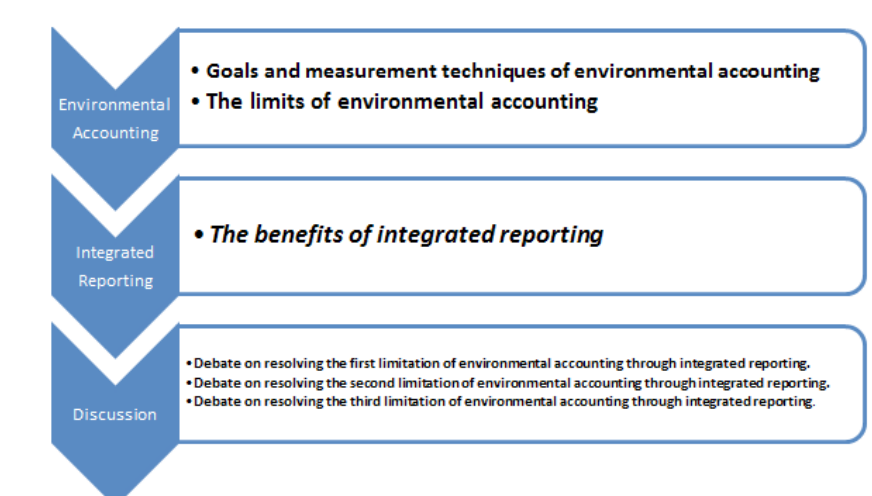
Figure 1. General research